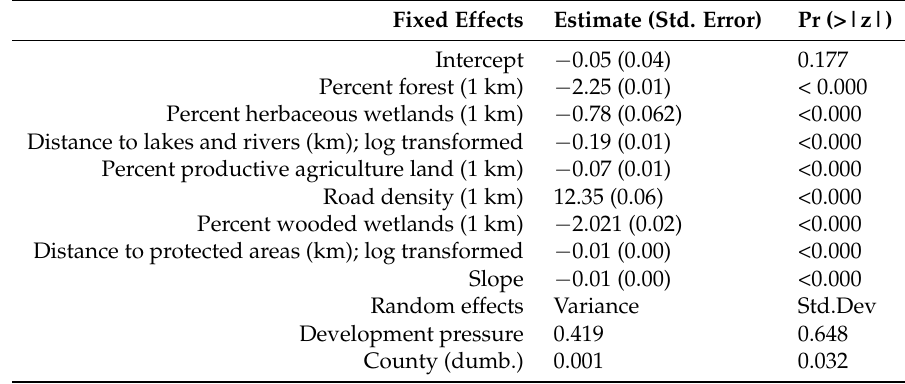
Table 2. Mixed effect model estimates for development suitability. Random effects are calculated per county ( n = 573) with considerable variation between probability of development for the county (intercept) and the importance of development pressure across